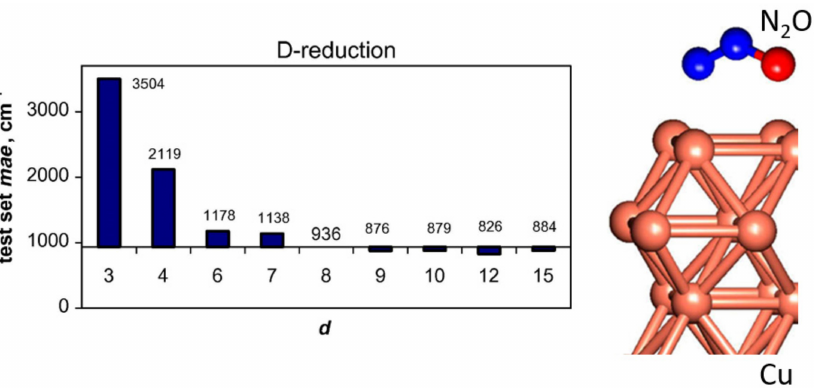
Figure 5. Test set mean absolute error (mae) of the interatomic potential of N 2 O over Cu (the system shown on the right) as a function of the dimensionality of a single component function of Red-RS-HDMR-NN. Reproduced with permission from [123]. Copyright 2010